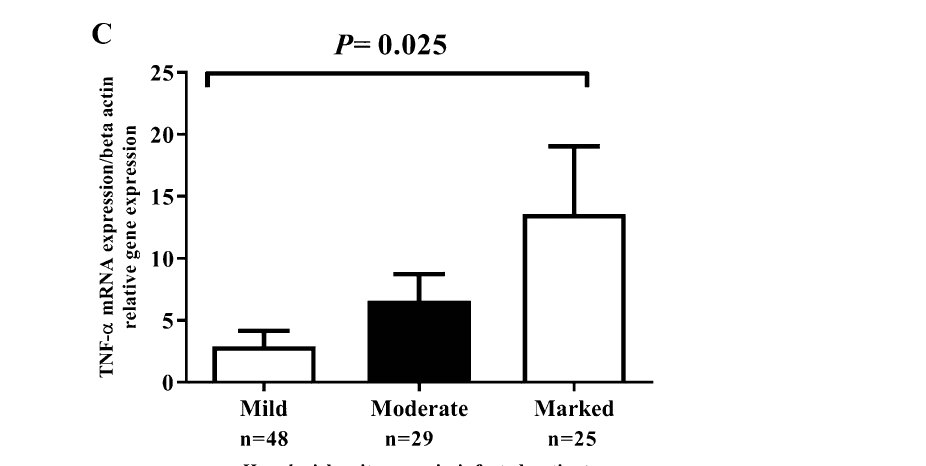
Fig. 6 The correlation between TNF‑α mRNA expression and acute inflammatory score, chronic inflammatory score and the grad of the density of H. pylori infection in patients. Increase in acute inflammatory score, the score of chronic inflammation and the H. pylori density grade is significantly related to increase TNF‑α mRNA expression in infected patients. P < 0 .05 was determine statistically significant by one‑way ANOVA (N